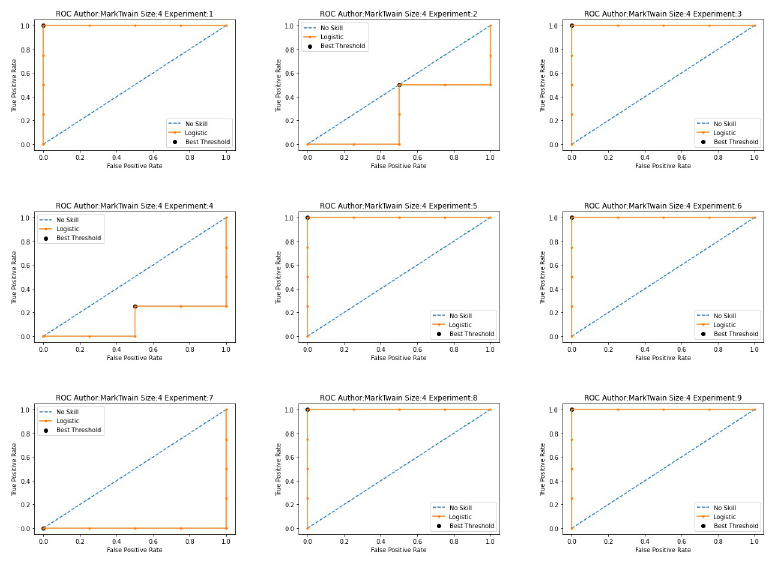
Fig 14. AUC of Mark Twain (MT) using syntactic relationship 3-gram via different threshold.